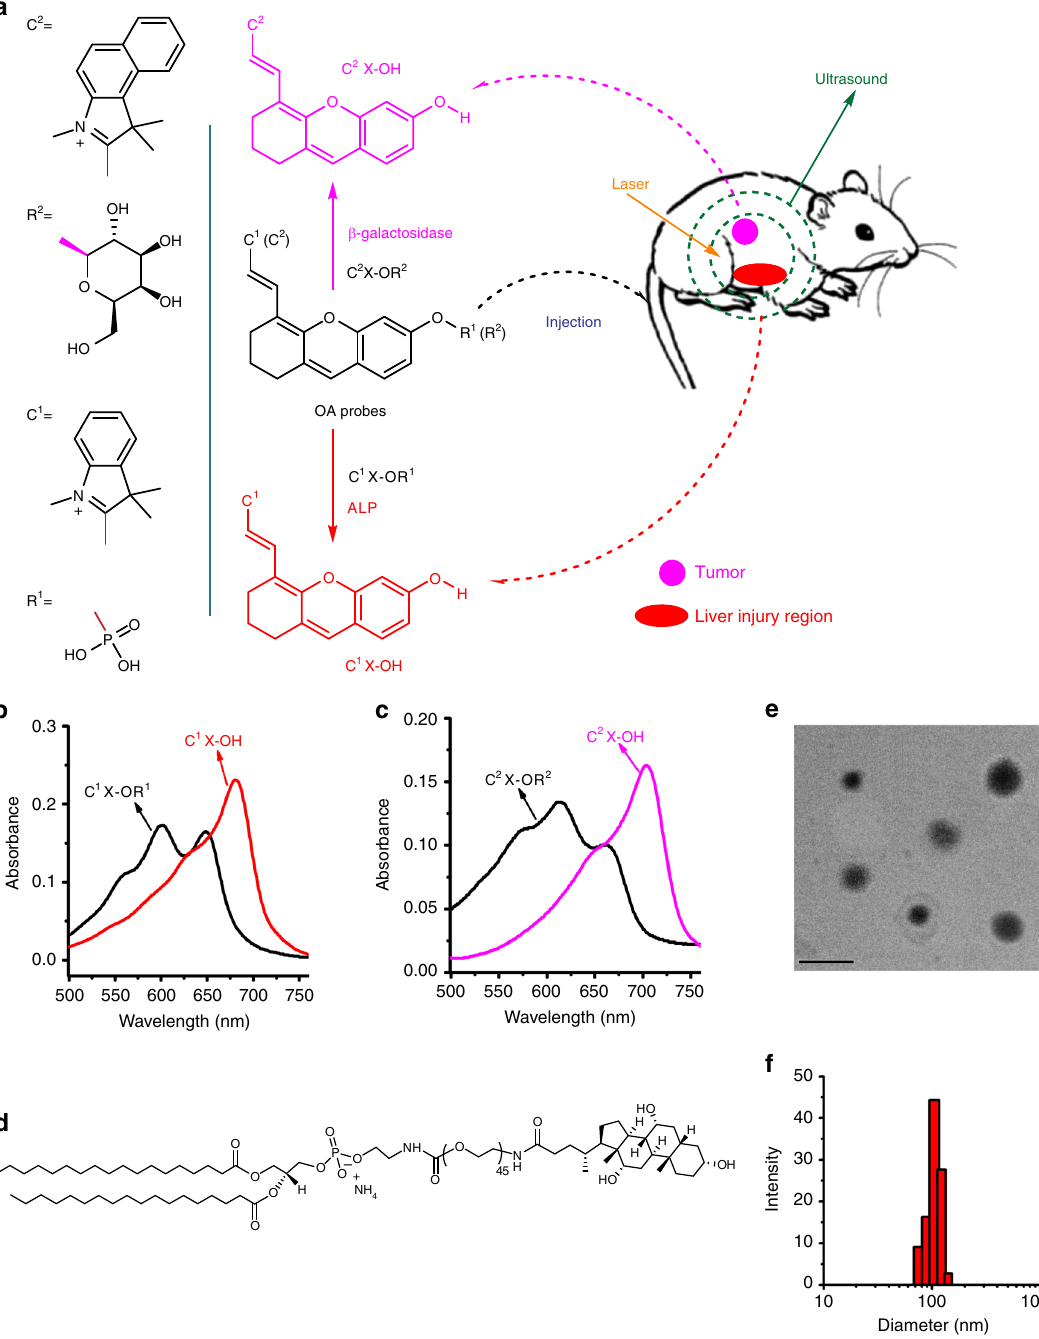
Fig. 1 Schematic illustration for the probes ’ response in vivo and related properties. a Schematic illustration for two xanthene-based molecules (C 1 X-OR 1 and C 2 X-OR 2 ) as the activatable OA probes for respectively imaging liver injury and metastatic tumor. b and c Absorption spectra for the probes (5 μ M) and their corresponding activated forms (C 1 X-OH and C 2 X-OH, 3 μ M). d Structure of a hepatocyte-targeting phospholipid for liver targeting. e and